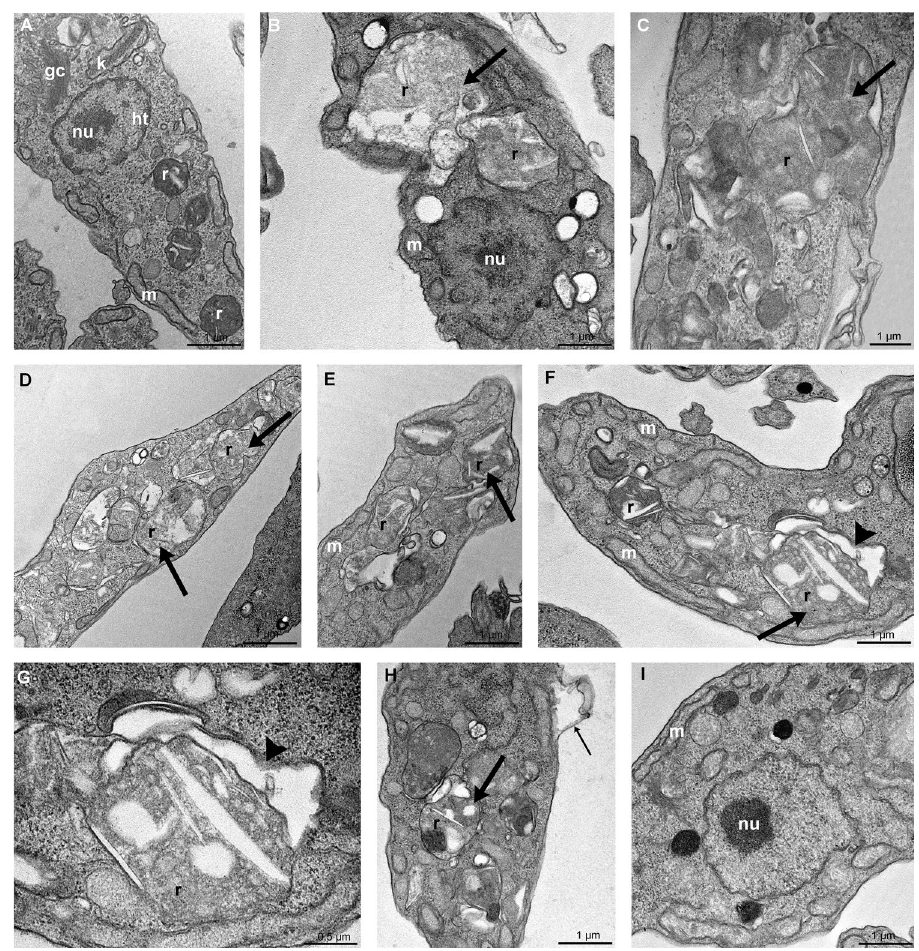
Figure 5. Transmission electron microscopy of T. cruzi epimastigotes in the presence of FEX for 72 h. ( A ) Non-treated epimastigote with the Golgi complex (GC) near the bar-shaped kinetoplast (k), the nucleus with the condensed heterochromatin (ht) close to the nuclear envelope and around the nucleolus (nu), a single branched mitochondrion (m) and reservosomes (r) at the posterior end. ( B – E ) Treatment with 20 µM ( B , C ) and 30 µM ( D , E ) caused a loss of rounded shape and matrix content of the reservosomes (thick arrow). ( F – I ) Treatment with 40 µM also caused the detachment of the reservosomes from the cytoplasm ( F , G , arrowhead), detachment of the plasma membrane ( H , thin arrow), and the unpacking of nuclear heterochromatin ( I ).